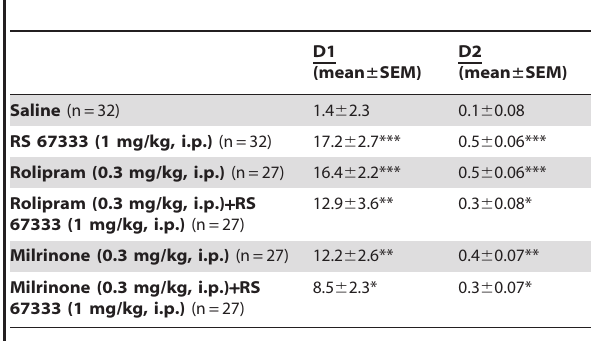
Table 3. Value of the index measures of discrimination in the object recognition